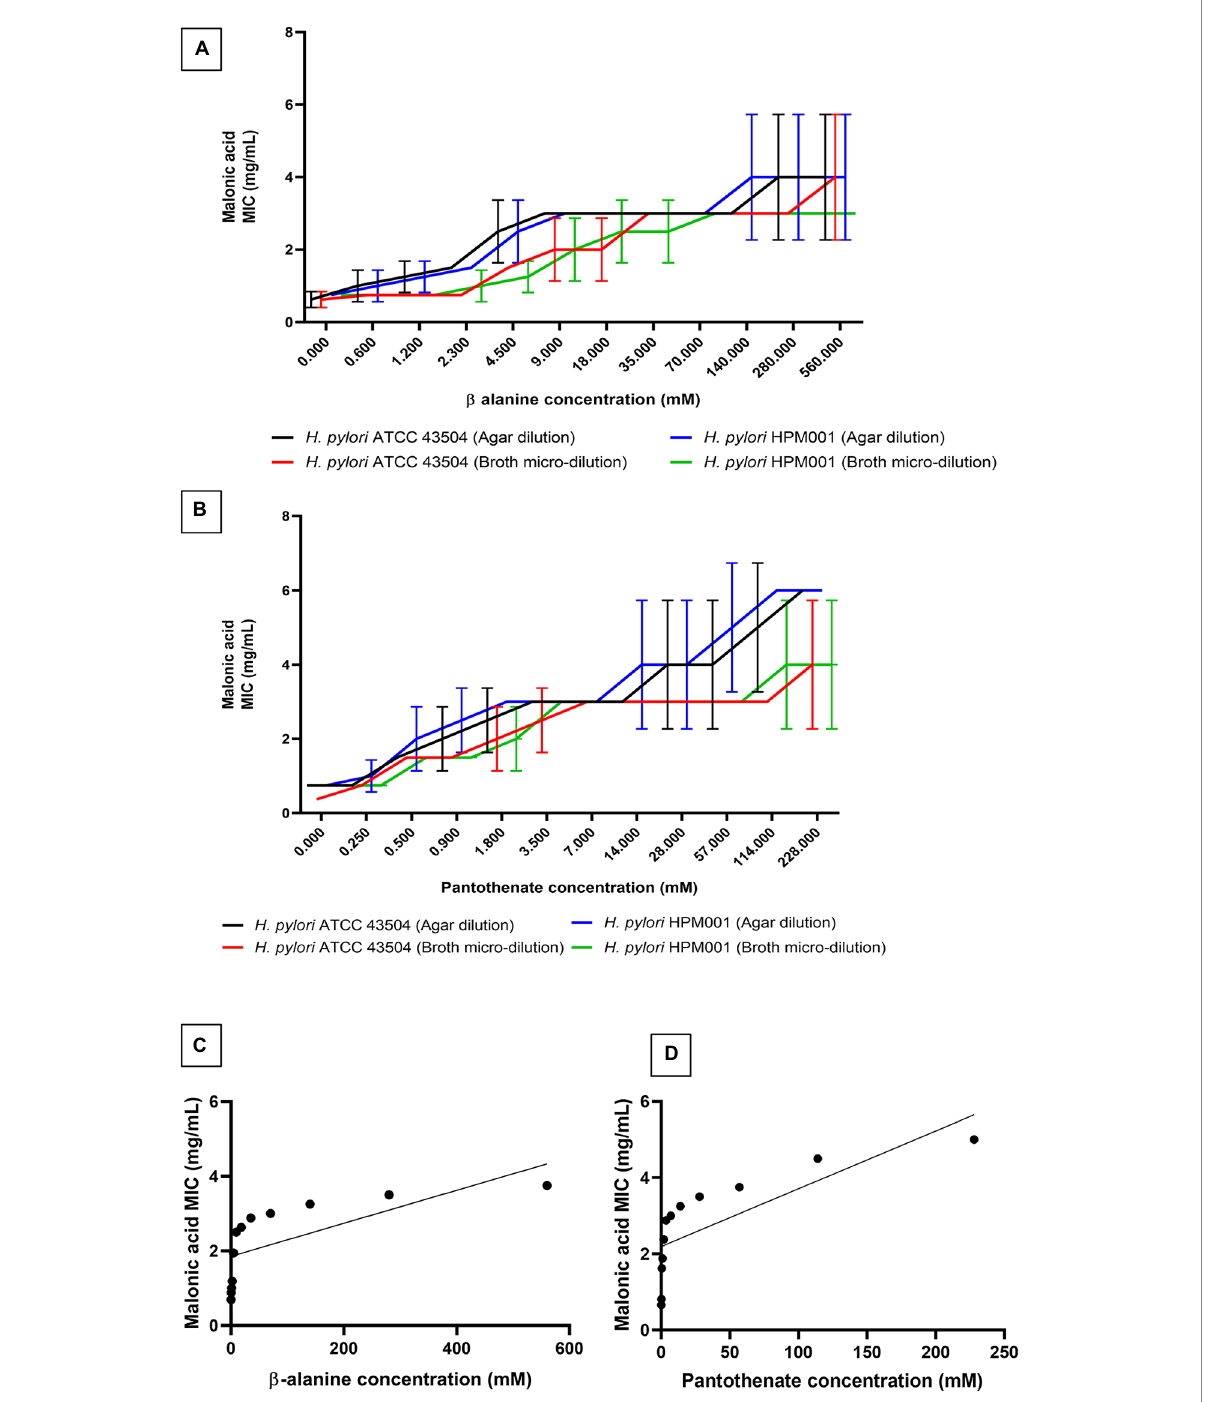
FIGURE 2 Minimum inhibitory concentration (MIC) of malonic acid in presence of the products of aspartate α -decarboxylase catalyzed enzymatic reaction. MIC of malonic acid in the presence of increasing concentrations of (A) β -alanine and (B) pantothenate, using both agar dilution and broth microdilution methods, against both Helicobacter pylori ATCC 43504 and the clinical H . pylori isolate (HPM001). The correlation between the MIC of malonic acid and the concentrations of (C) β -alanine, and (D)